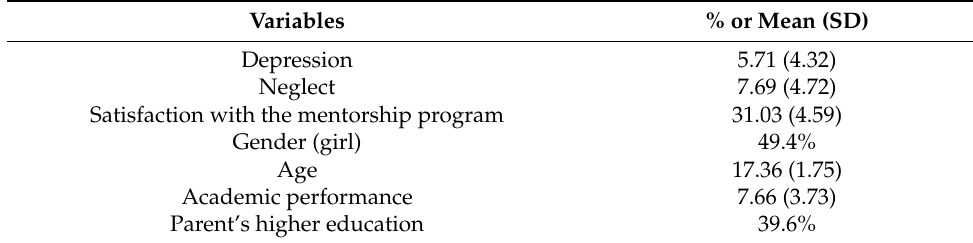
Table 1. Descriptive